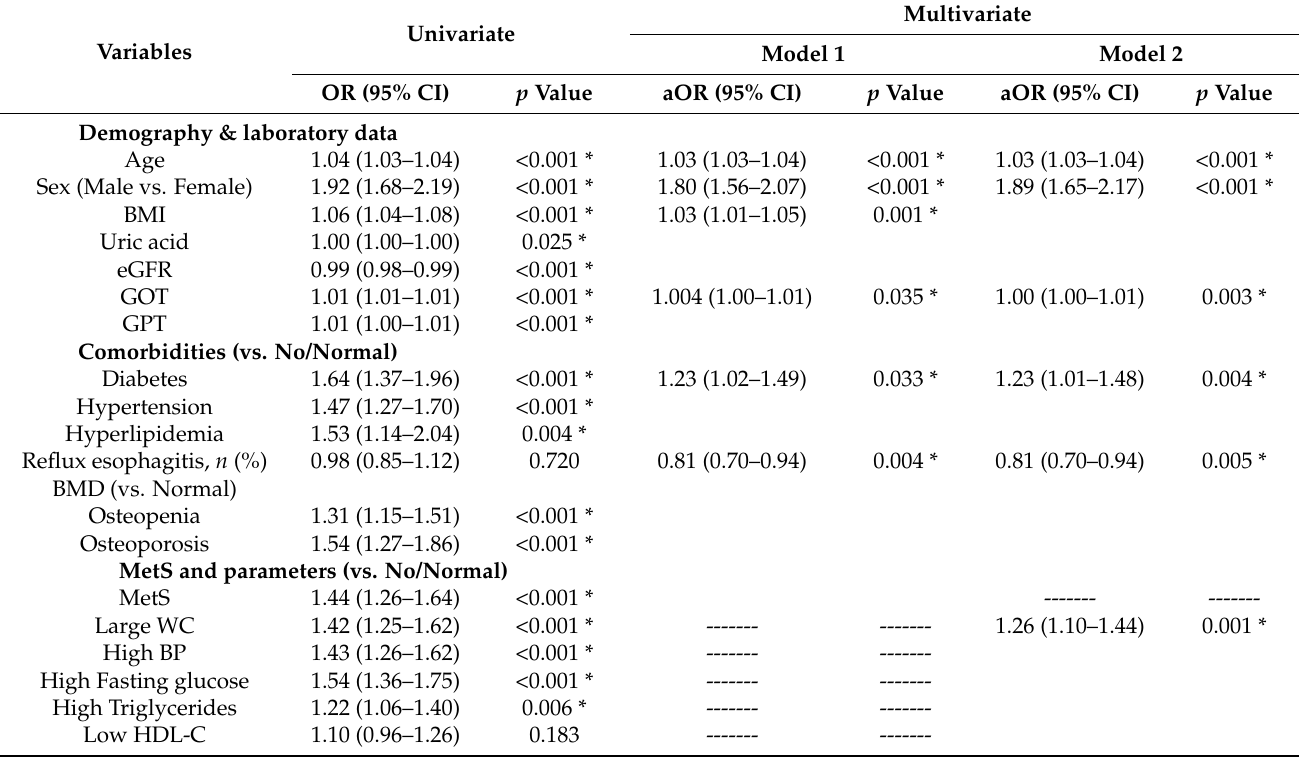
Table 2. Risk factors for peptic ulcer